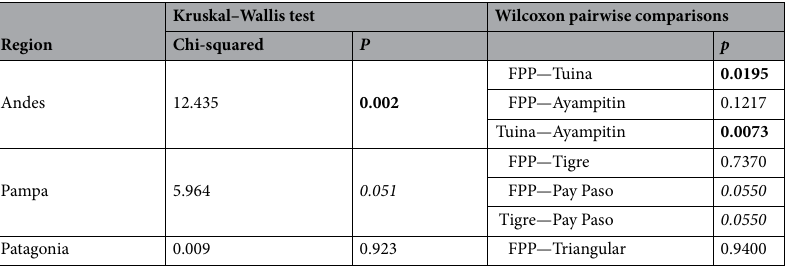
Table 1. Non-parametric mean differences tests among projectile point groups in TCSP index. The Kruskal– Wallis test evaluate the significance of TCSP index differences within geographical regions, whereas the Wilcoxon pairwise comparisons evaluate the significance of differences between all pair of projectile point types within each region. Values in bold indicates significant differences and values in italics marginally significant